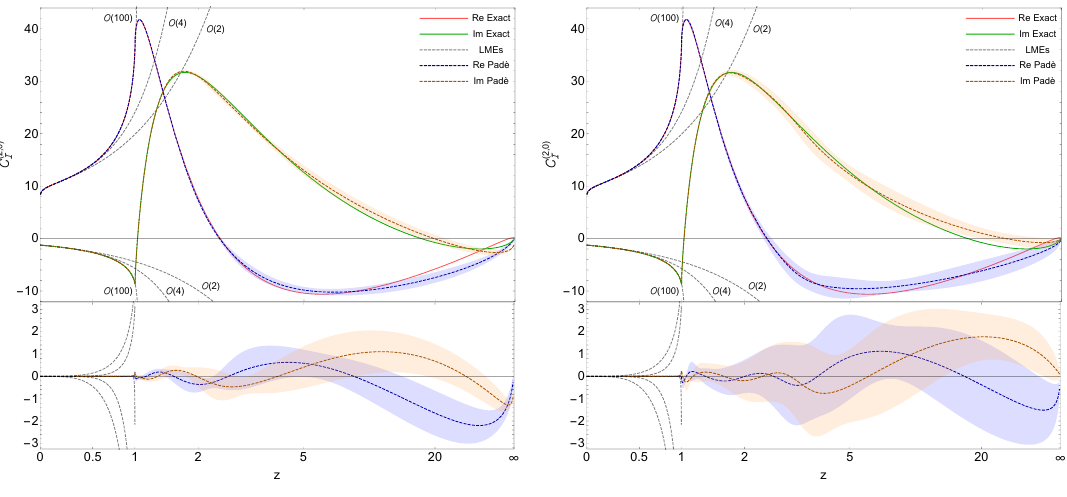
Figure 5 . Same as (cid:12)gure 4 but with n l =